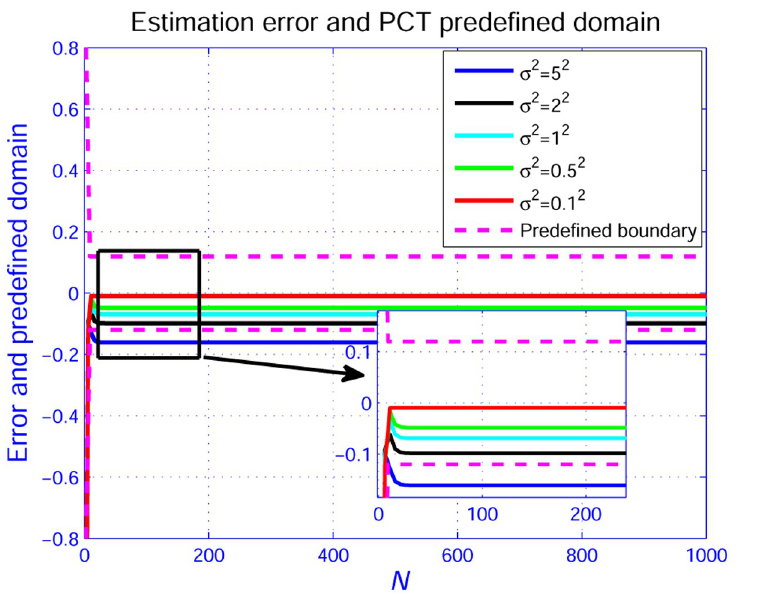
Fig 10. Estimation error